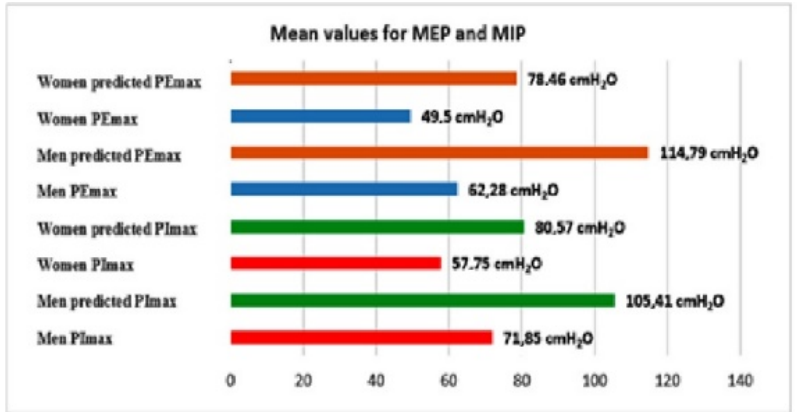
Figure 1. Comparison of values for maximal inspiratory pressure (MIP) and maximal expiratory pressure (MEP) from the assessed group compared to the predicted values on literature.